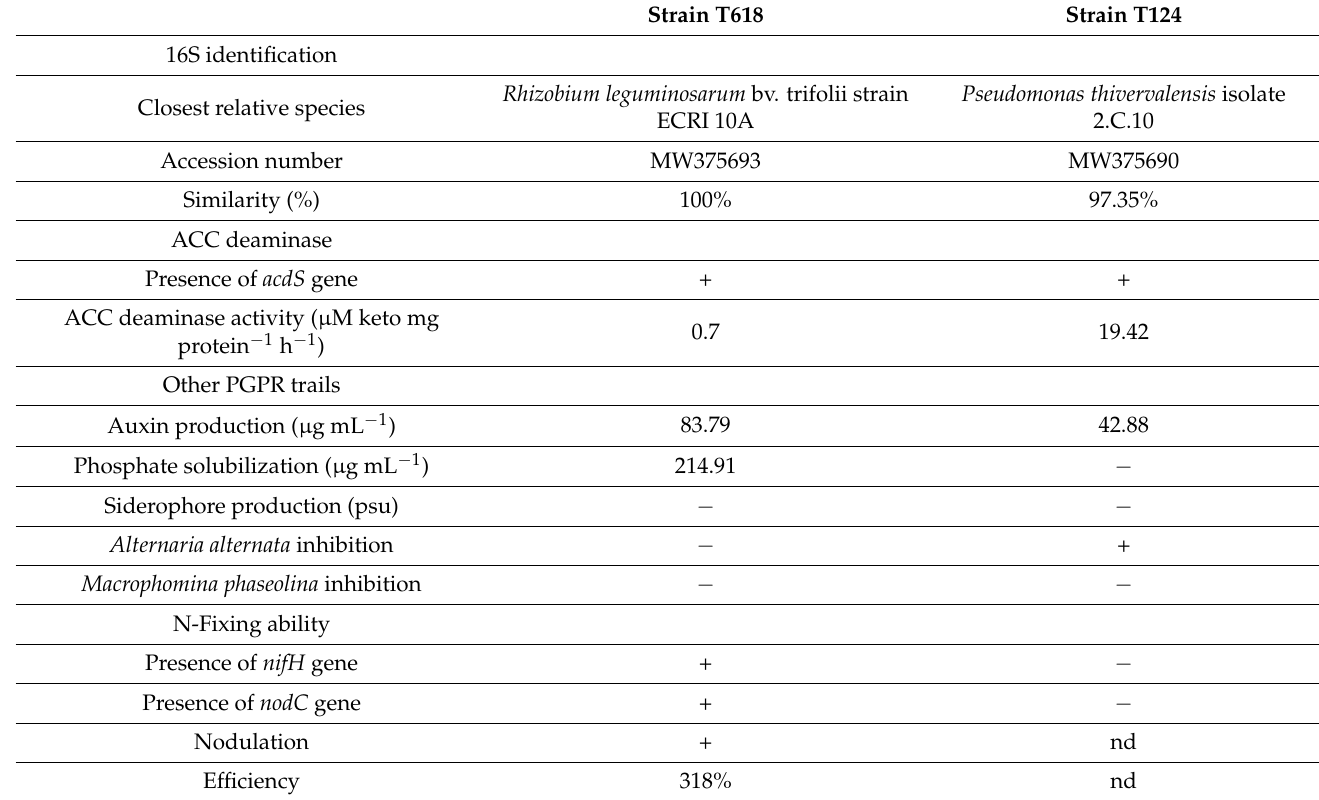
Table 1. 16S identification, plant growth-promoting traits, and symbiotic characteristics of T618 and T124 selected